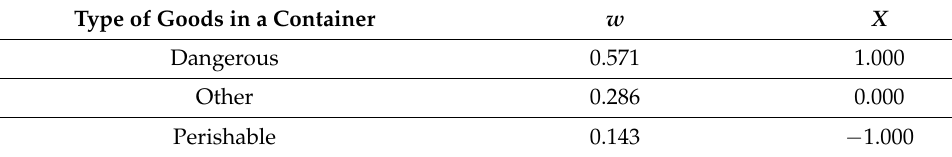
Table 8. Ranking of the cargo type in a container according to retention time.